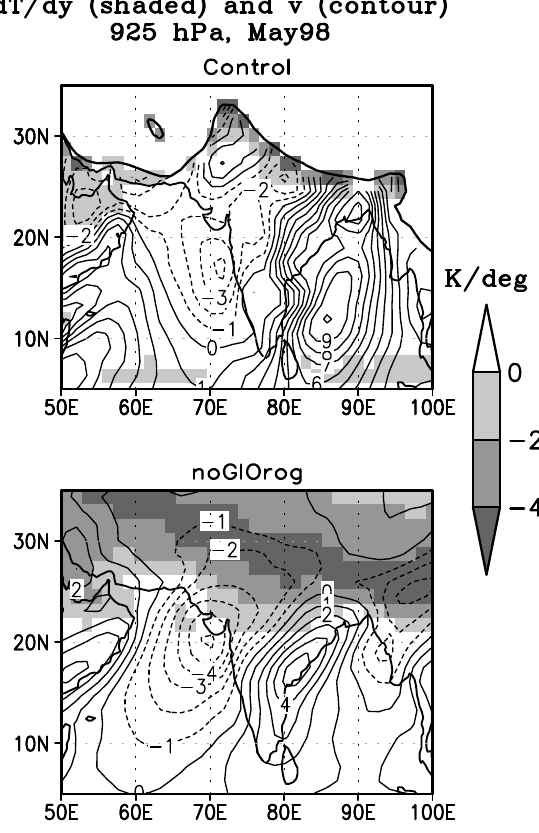
Fig. 6. Meridional gradient of air temperature (shaded) and merid- ional velocity (contour) at 925hPa in the control and noGlOrog sim- ulations during May. In the noGlOrog simulation, a negative north- south gradient of air temperature (signifies more cold air toward north), along with a southward flow, advects cold air and reduces the dry static energy over the Indian region. This advection is most prominent west of 80 ◦ E.